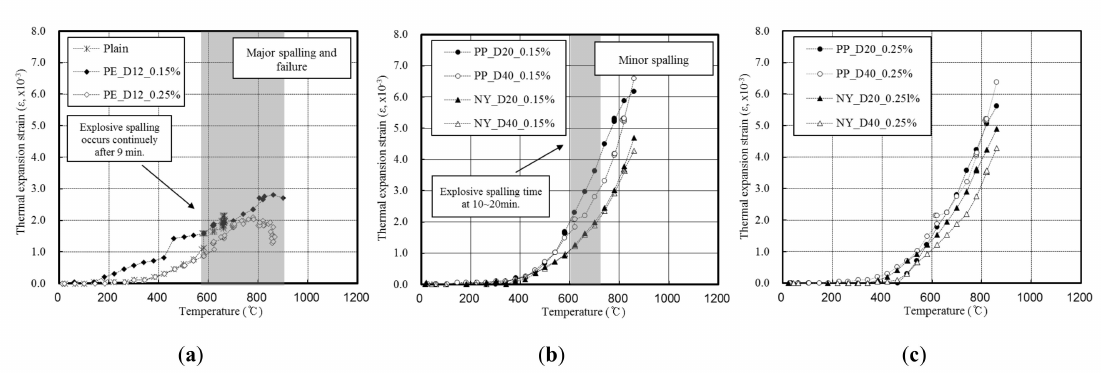
Figure 10. The rmal strain of the fiber-mixed concrete specimens with: ( a ) Major spalling; ( b ) minor spalling; ( c ) no